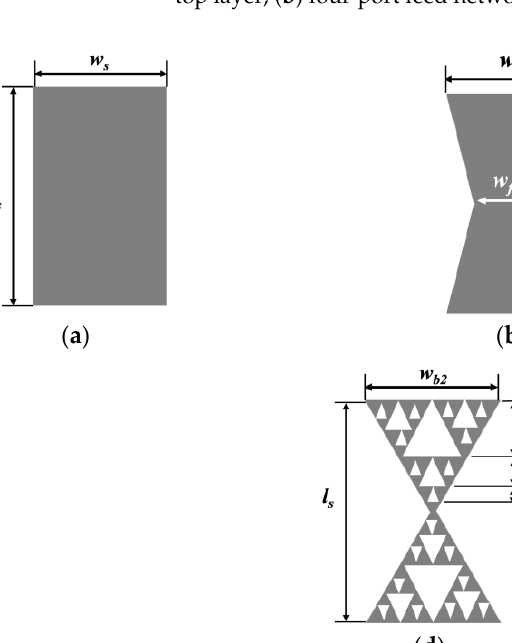
Figure 2. ( a ) Quad-band uniformly spaced array displacement with four elements for each band on top layer; ( b ) four-port feed network to evenly distribute signals in terms of magnitude and phase.